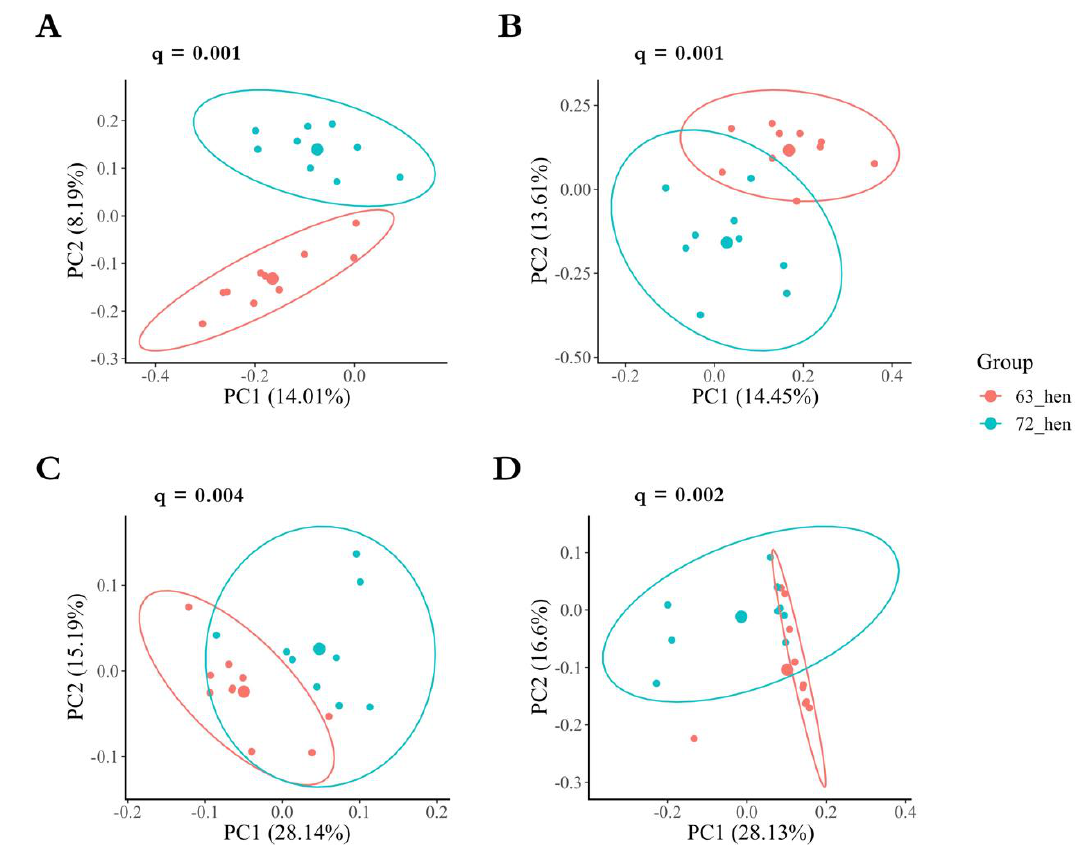
Figure 3. Principal coordinates analysis (PCoA), which shows the similarity between two diversely selected chicken lines. ( A ): Bray – Curtis similarity, ( B ): Jaccard similarity, ( C ): unweighted UniFrac, and ( D ): weighted UniFrac distances with 95% confidence ellipses.